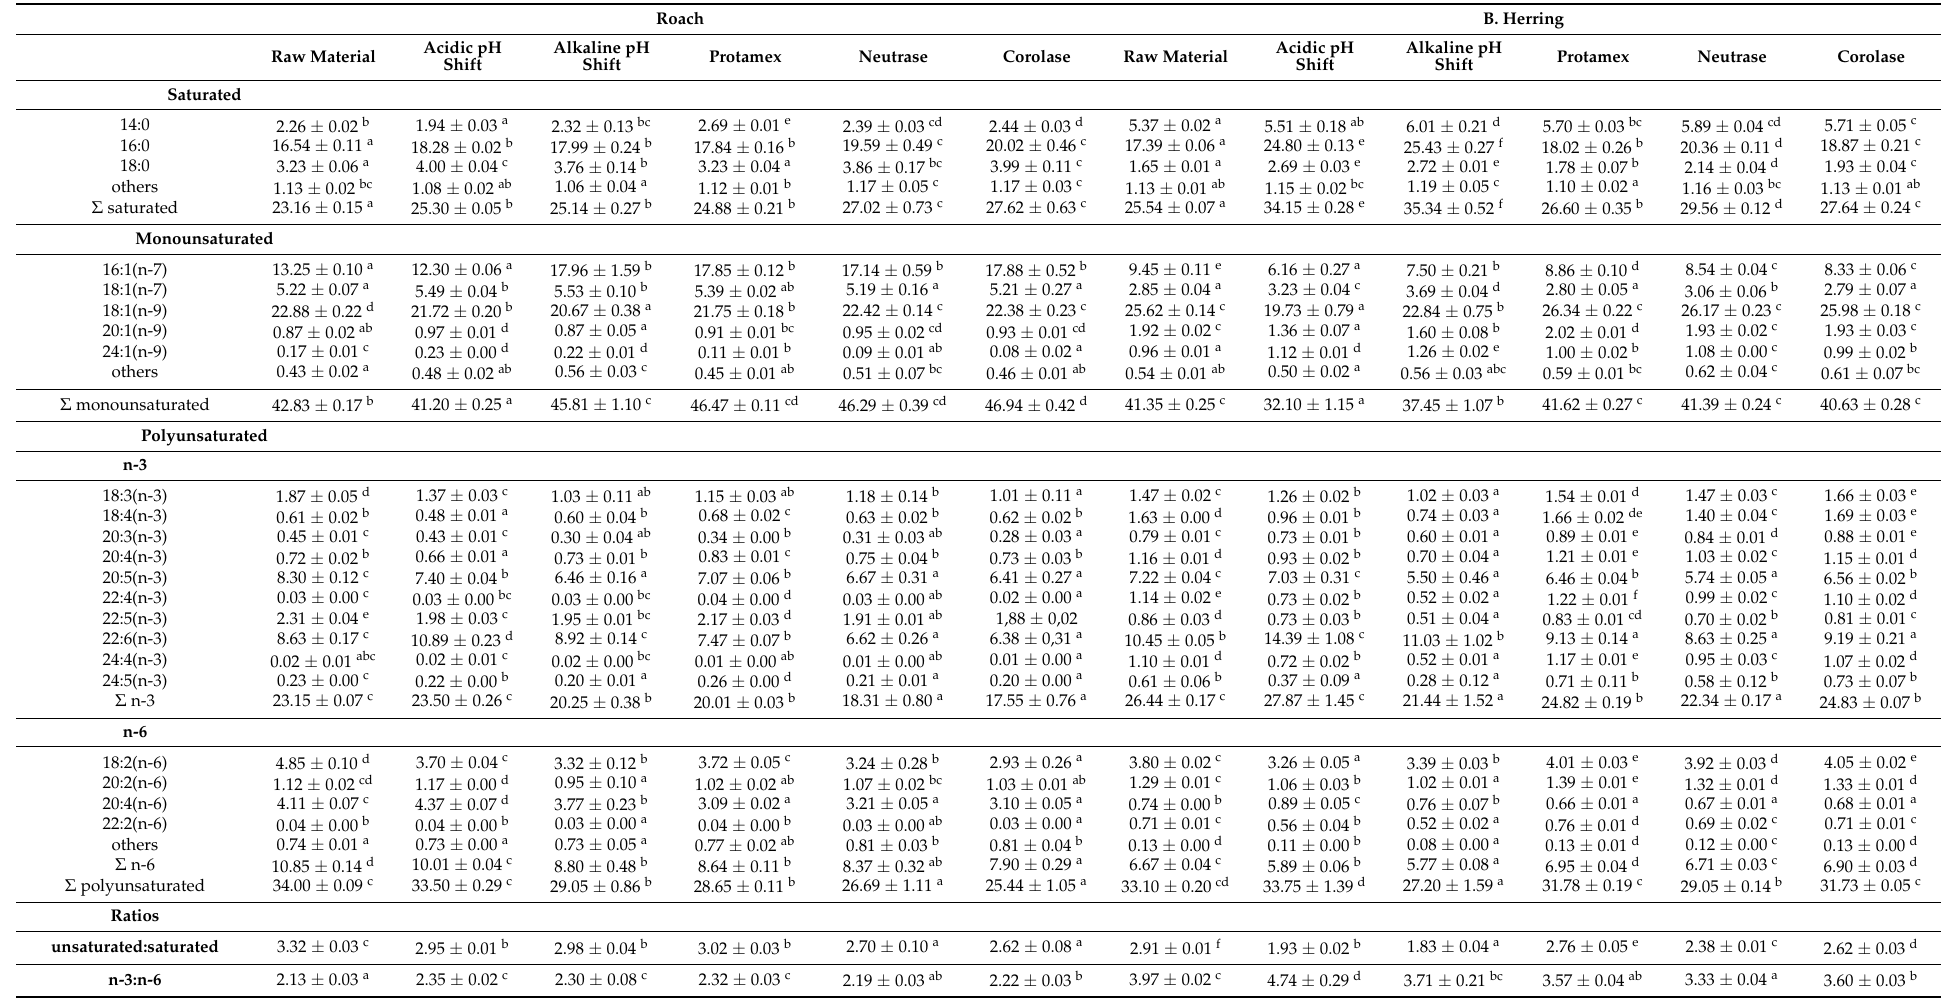
Table 3. Fatty acids (mg/100 mg of total fatty acids) in roach, B. herring, and protein isolates and hydrolysates, obtained using acidic or alkaline pH shift process or enzymatic fractionation using Protamex, Neutrase, or Corolase. Different letters on the same row and within the same raw material indicate a statistically significant difference between samples ( p <